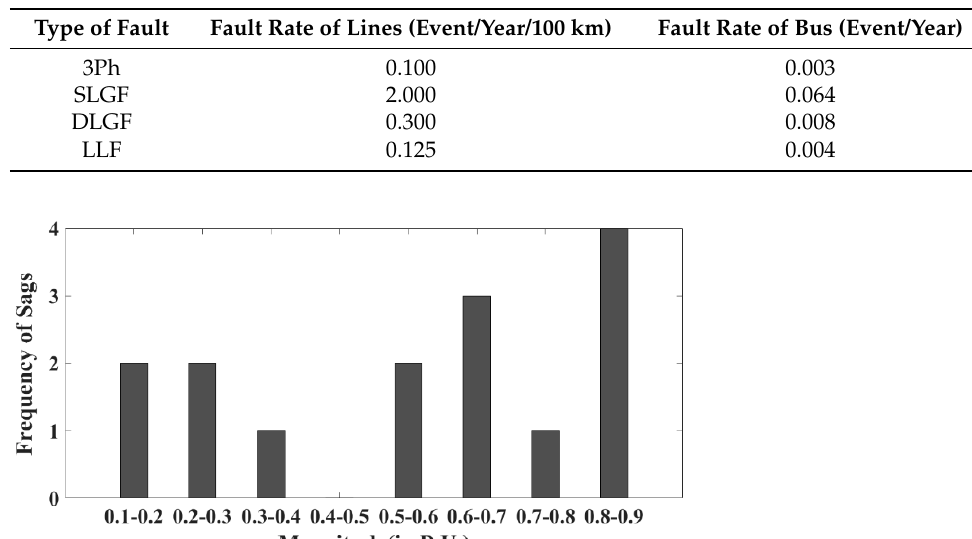
Figure 10. Distribution network of the district of Haridwar. Table 3. Fault rate of the lines and buses.